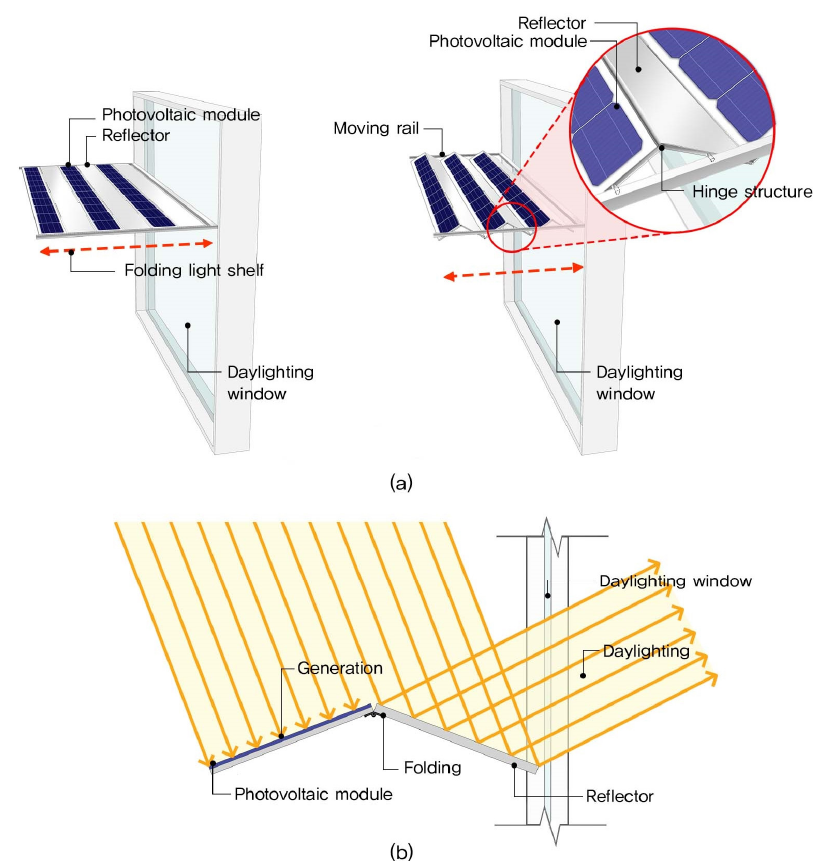
Figure 3. The concept and principle of the light shelf that applies folding technology and photovoltaic modules: ( a ) Structure of proposed system, ( b ) Daylighting and generation by the proposed system.